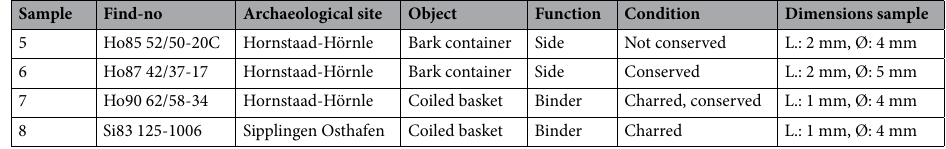
Table 2. Samples from archaeological